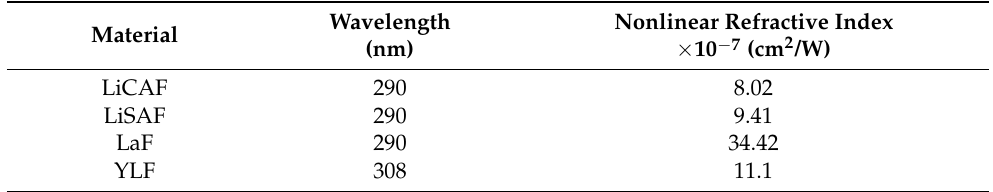
Table 4. Peak laser emission wavelength and nonlinear refractive index ( n 2 ) of the fluoride laser materials at their respective peak laser emission